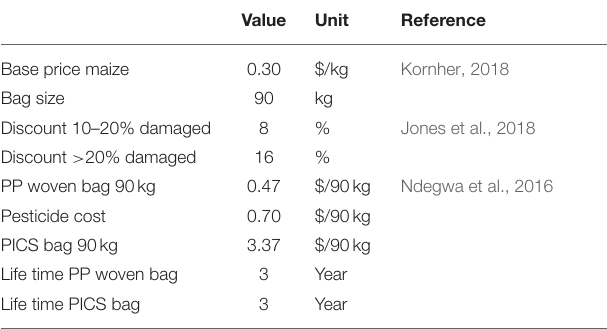
were considered. These calculations took into consideration three TABLE 4 | Parameters used to calculate in-house price during